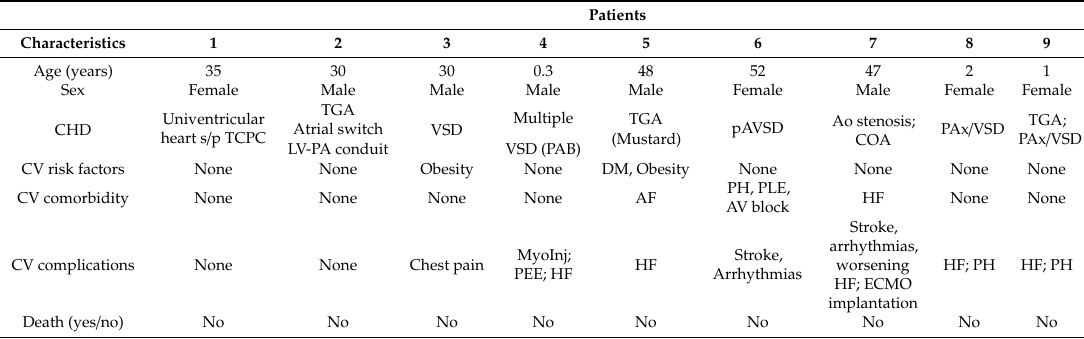
Table 2. Characteristics of 9 patients with Congenital Heart Disease infected with COVID-19. No CHD = congenital heart disease; CV = cardiovascular; TCPC = total cavopulmonary connection; TGA = transposition Patients of the great arteries; LV = left ventricle; PA = pulmonary artery; PAx = pulmunary atresia; VSD = ventricular Characteristics septal defect; pAVSD = partial atrioventricular septal defect; PAB = pulmonary artery banding; DM = diabetes mellitus; AF = atrial fibrillation; PH = pulmonary hypertension; PLE = pleural e ff usion; HF = heart failure; MyoInj = myocardial injury; PEE = pericardial e ff usion; COA = coarctation of the